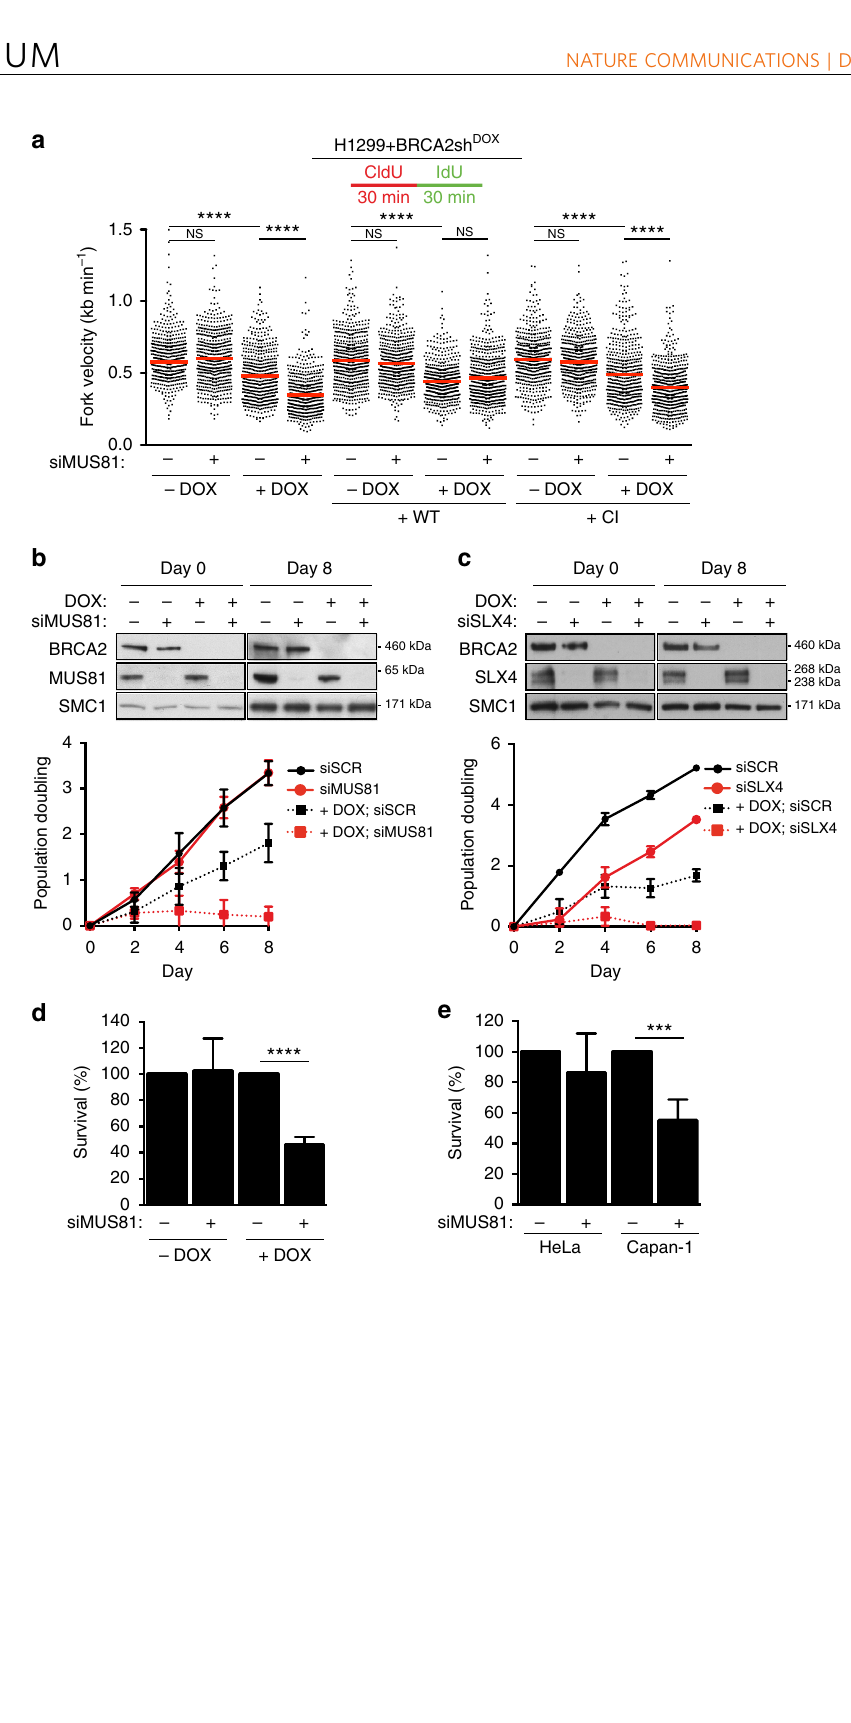
2 NATURE COMMUNICATIONS|8:16171|DOI: